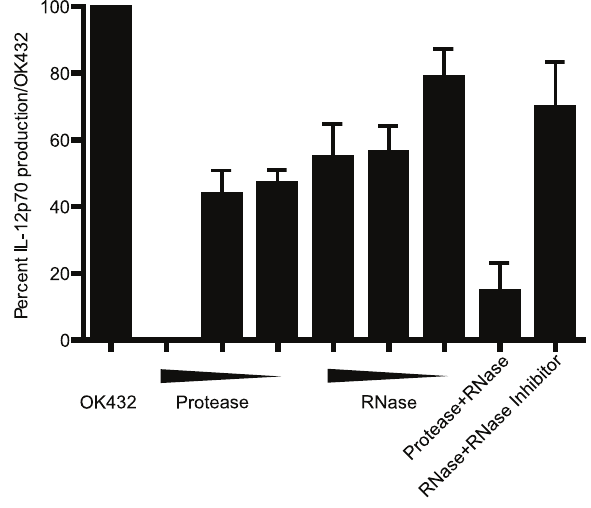
Figure 4. OK432 mediates its effect via TLR3 by a ligand that needs RNA and protein present. OK432 was pre-treated with RNase A and protease K for 30 minutes at 37 u C before being diluted 25-fold and added to the DC. The pre-treatment was performed with 100, 10 and 2 m g/ml protease K, and RNase A was tested at 100, 10 and 1 m g/ ml. After 24 hours the supernatants were analyzed for presence of IL- 12p70. The amount produced is displayed as a percentage compared to that of OK432 alone set to 100%. Protease K treatment diminished IL- 12p70 production in a dose-dependent manner. RNase reduced the IL- 12p70 production by more than 50%, while the combination of protease K and RNase treatment reduced the IL-12p70 production by around 90%. IL-12p70 production was rescued by adding a RNase inhibitor together with the pre-treatment. For each treatment, the mean and SEM is shown (N=2–4